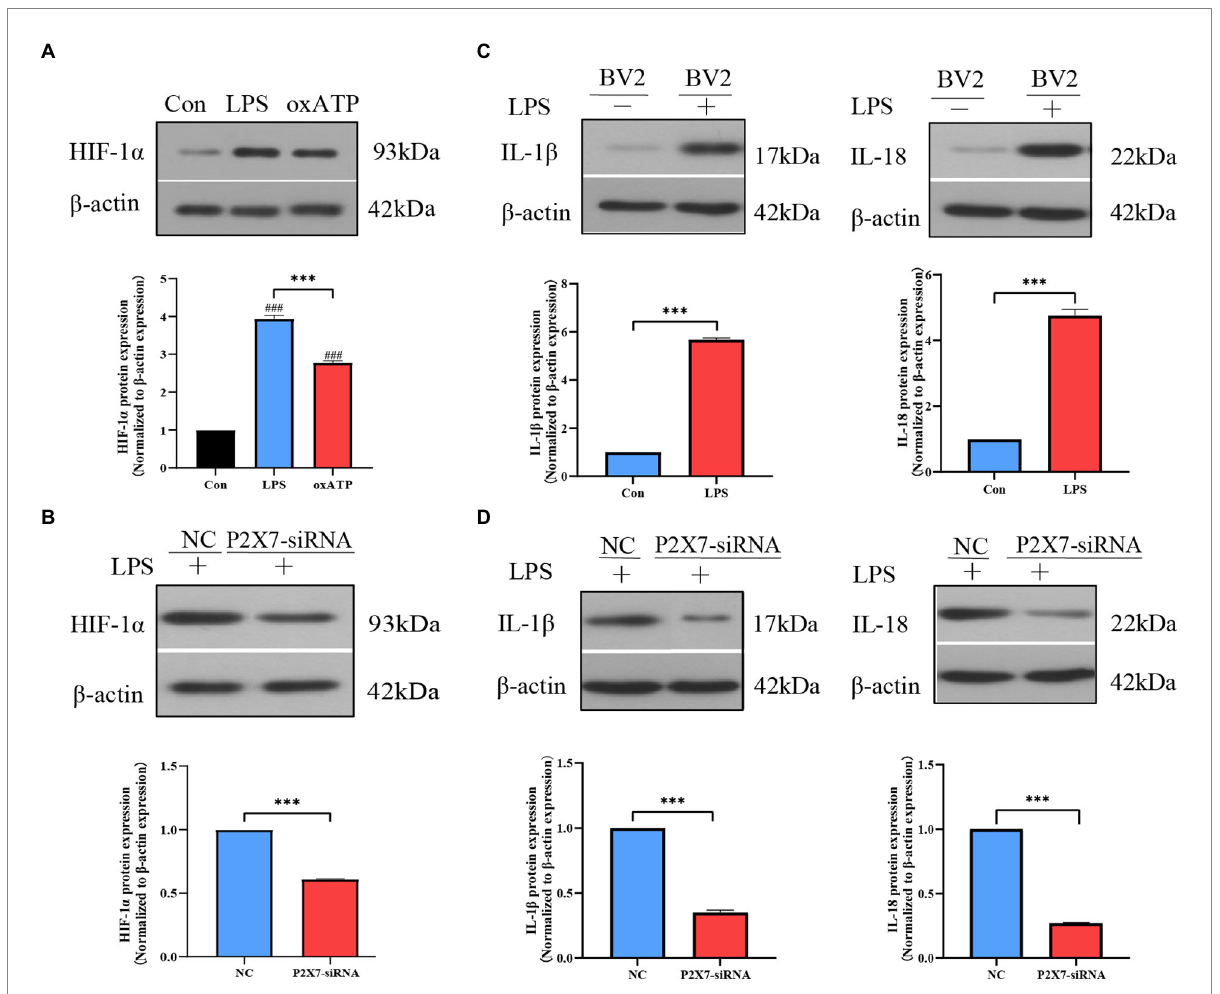
FIGURE 5 Effects of P2X7 on HIF-1 α expression and inflammatory factors levels in BV2 cells. (A) Western blot results showed that LPS-induced upregulation of HIF-1 α expression which was inhibited by oxATP. ### p < 0.001 vs. control, *** p < 0.001 vs. LPS group. (B) HIF-1 α expression was downregulated with P2X7 siRNA pretreatment. *** p < 0.001 vs. negative control group. (C) LPS induced upregulation of IL-1 β and IL-18. *** p < 0.001 vs. control. (D) The protein expression levels of IL-1 β and IL-18 in BV2 cells treated with siRNA against P2X7. *** p < 0.001 vs. negative control